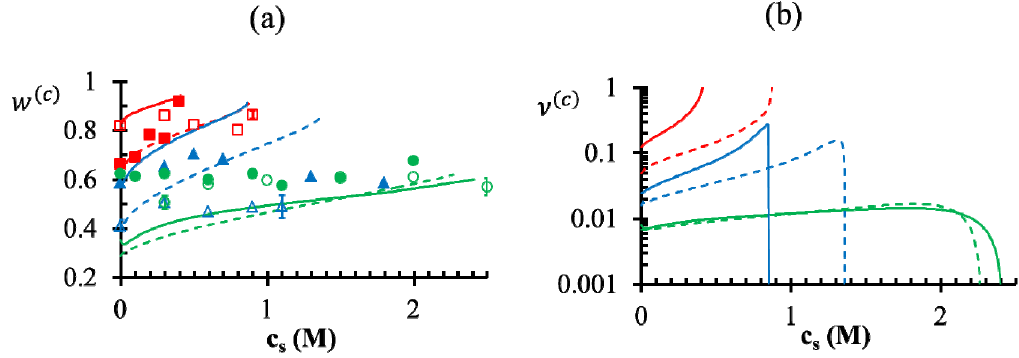
Figure 7. Theoretical and experimental predictions of ( a ) weight fraction of water in the coacervate and ( b ) volume fraction of coacervate, as a function of salt concentration for different pH values. Legends: PAA-PDMAEMA-KCl (dashed lines for theory and open symbols for experiments), PAA-PDADMAC-KCl (bold lines for theory and filled symbols for experiments), pH = 4 (green lines and symbols), pH = 5 (blue lines and symbols), and (PAA) = 0.75 is used for theoretical predictions in pH = 7 (red lines and symbols). (cid:2031) (cid:2879)(cid:3050) ( a ) and ( b ). We expect an error up to 20% in the experimental results of (cid:1875) ((cid:3030)) (corresponding to ±5 water wt%), as estimated for some cases in Figure 7a using results from three independent